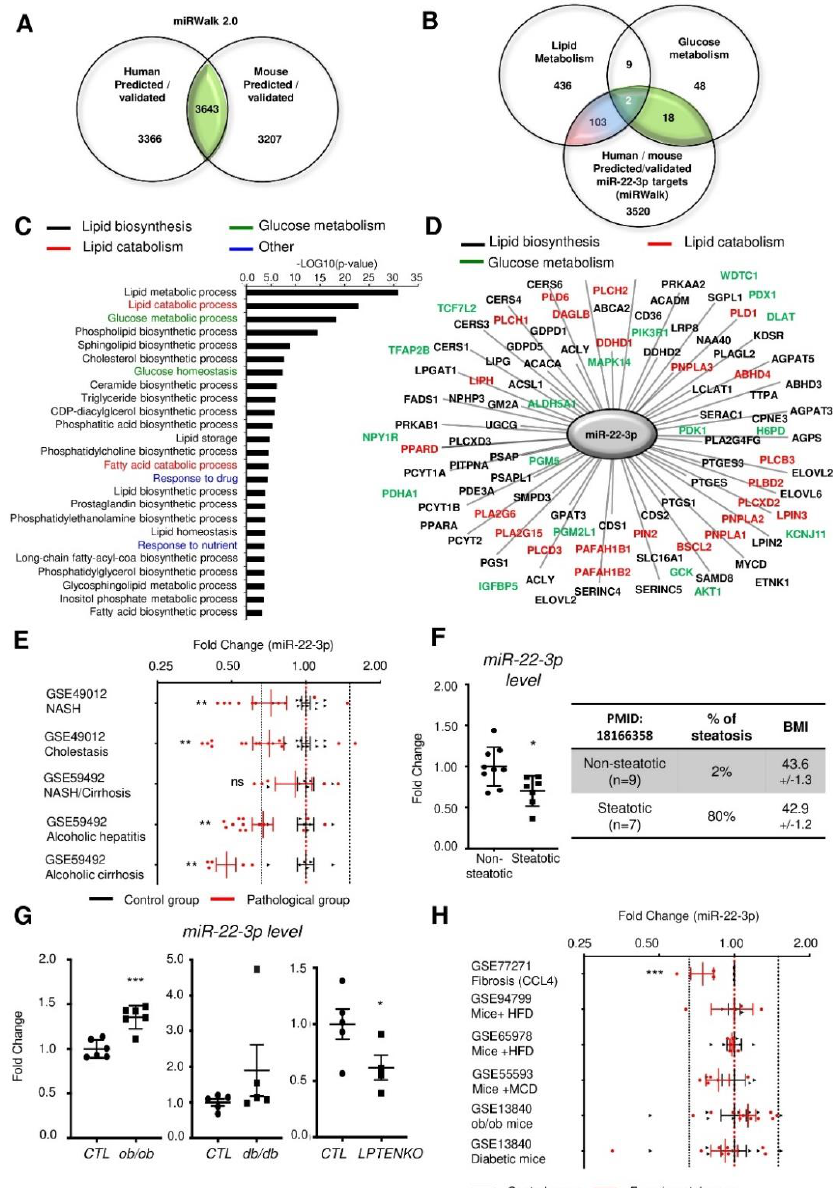
Figure 1. MiR-22-3p expression in the liver is not a reliable marker of non-alcoholic fatty liver disease (NAFLD) and/or non-alcoholic steatohepatitis (NASH). ( A ) Comparison of validated and predicted miR-22-3p targets in mice and humans from the miRwalk 2.0 database. ( B ) Common targets between mouse and human in Panel A are compared with a list of lipid/glucose metabolism-related genes obtained with the MetaCore TM software (123 candidates). ( C ) The 123 candidates that were identified, were then subjected to a Gene Ontology analysis for biological processes. Genes enriched in lipid biosynthesis, lipid catabolism, and glucose metabolism biological processes are represented in ( D ). ( E ) Gene Expression Omnibus (GEO) datasets analyses of miR-22-3p expression in human fatty liver disease. ( F ) MiR-22-3p expression in human liver biopsies of non-steatotic (n = 9) and steatotic (n = 7) obese patients. ( G ) MiR-22-3p expression in liver tissues from 2-months old ob/ob, db/db and 4-months old LPTENKO (Liver-specific PTENKO mice) and their respective controls. ( H ) GEO dataset analyses of miR-22-3p expression in mouse fatty liver disease models (CCL4—carbon tetrachloride, HFD—high fat diet, MCD—methionine choline-deficient diet). Data represent the means ± standard error of the mean (SEM). * p < 0.05, ** p < 0.01, *** p < 0.001 compared with controls (Student